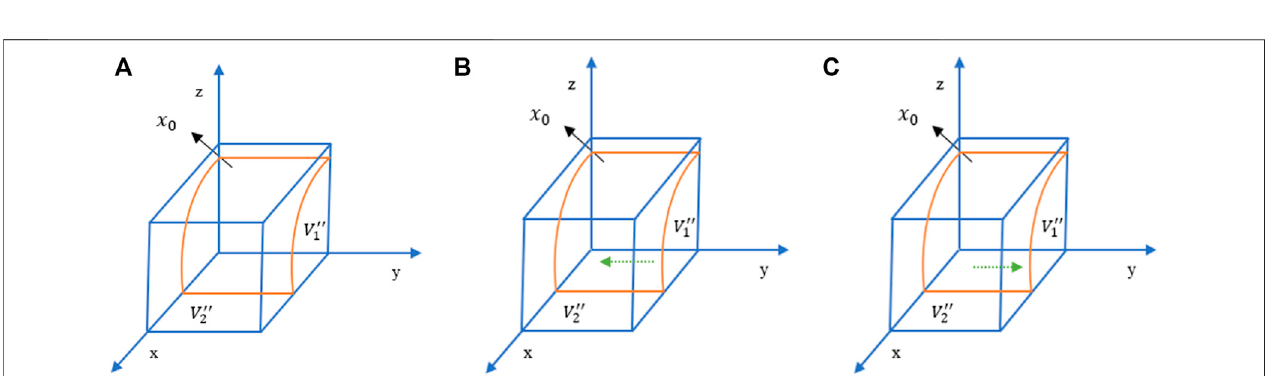
FIGURE 3 | Dynamic evolution trend of the behavior of the CP. (A) x − x 0 . (B) x < x 0 . (C) x > x 0 .